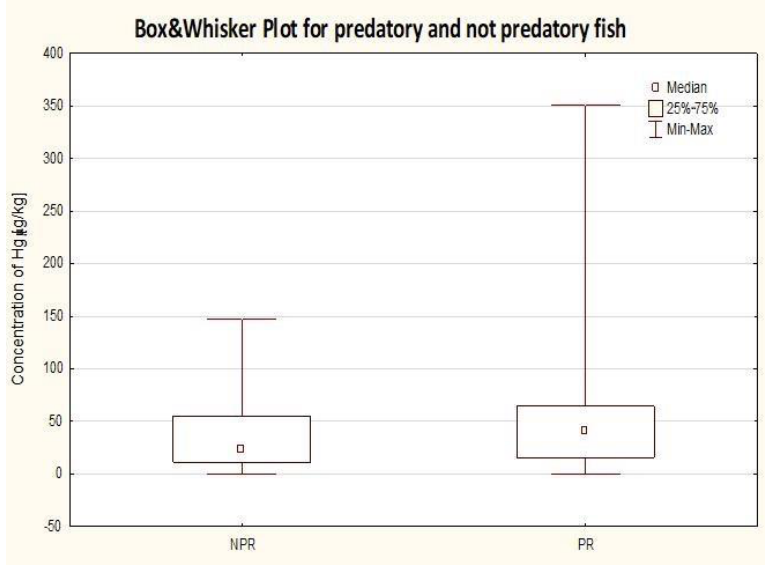
Figure 4. Box and whisker plot for content of Hg for predatory and non-predatory fish (NPR—non-predatory fish, n = 105, median = 24.1; PR—predatory fish, n = 147, median = 44.7; total n = 252) (µg/kg) .